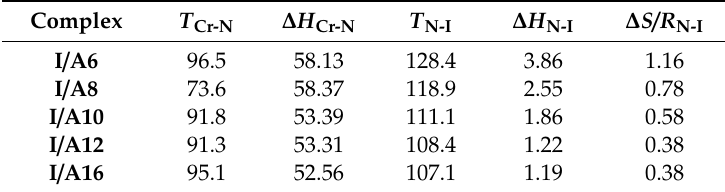
Table 1. Phase transition temperatures (°C), enthalpy of transitions (kJ/mol), and transition entropy for the supramolecular complexes I/An.